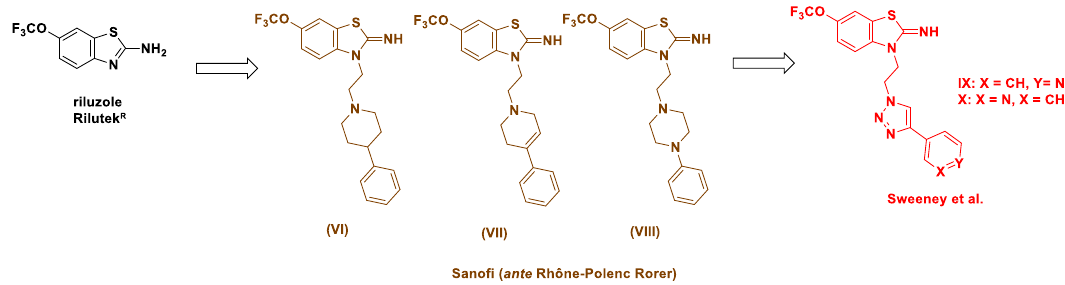
Figure 9. Chemical structures of the most potent hybrids of riluzole ( VI , VII , VIII , IX and X ).